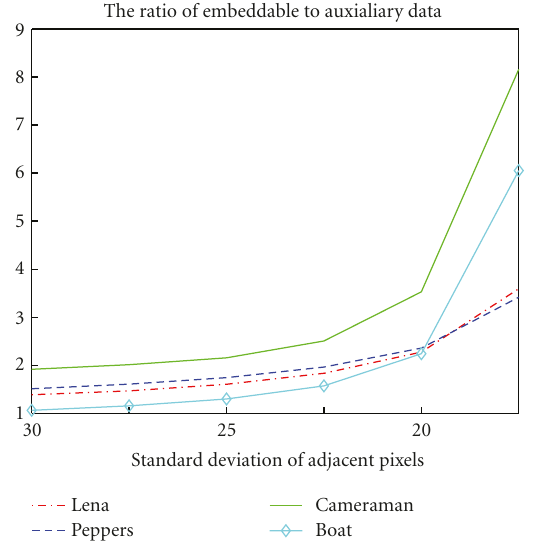
Figure 3: The relation of embeddable pixels to correction data.